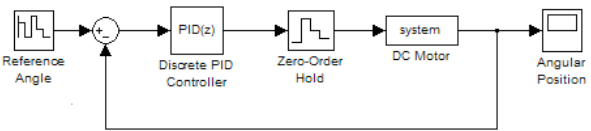
Figure 4: PID control strategy for a DC motor Figure 7. PID control strategy for a DC motor.